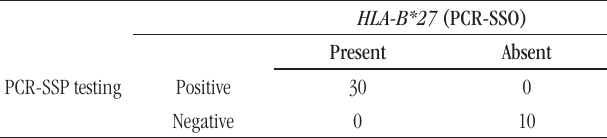
taBLE 3 − Positive and negative results for PCR-SSO and PCR-SSP